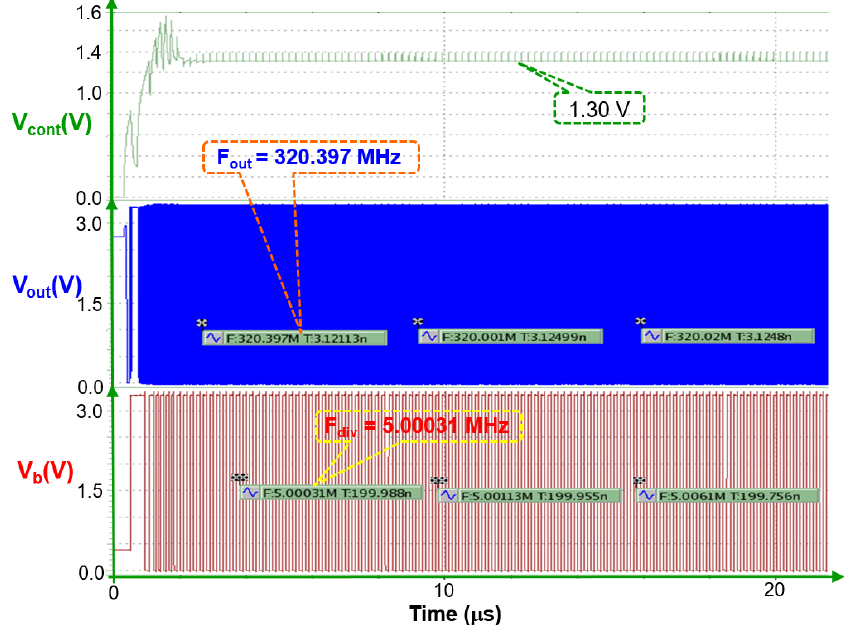
Figure 20. Simulated waveforms of the adopted FD at the control voltage V cont of 1.30 V. Figure 21 illustrates the post-layout simulated PSD of the proposed PLL-SAR ADC. According to the 32,768-point FFT simulation, the simulated SNDR was 58.23 dB,